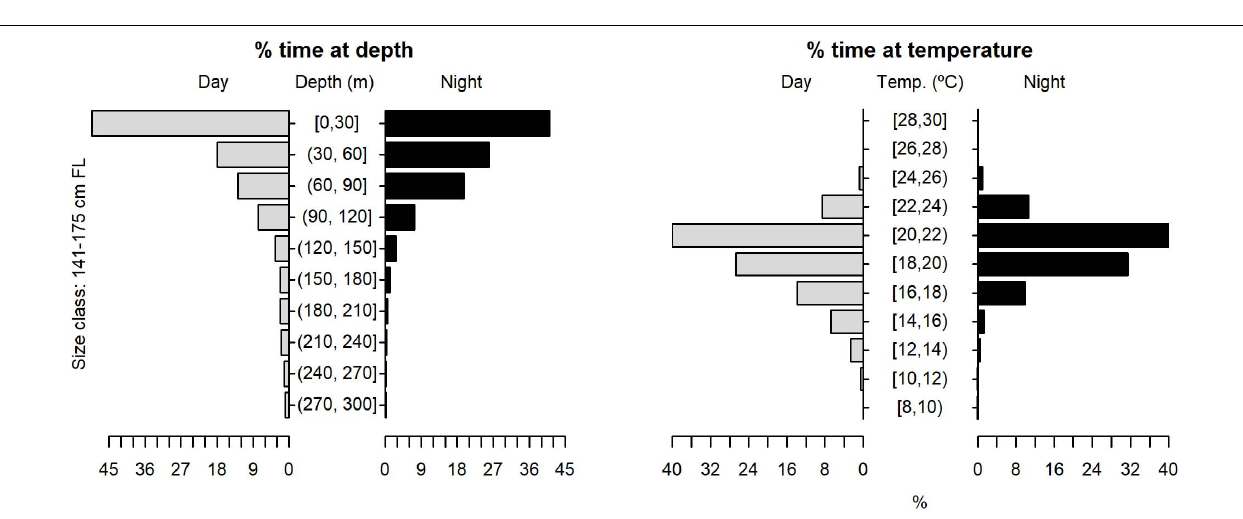
FIGURE 9 | Vertical habitat use of shortfin makos ranging in size from 141 to 175 cm FL, for daytime and night-time in terms of depth and temperature. Depth classes are categorized in 30 m intervals and temperature classes in 2 ◦ C